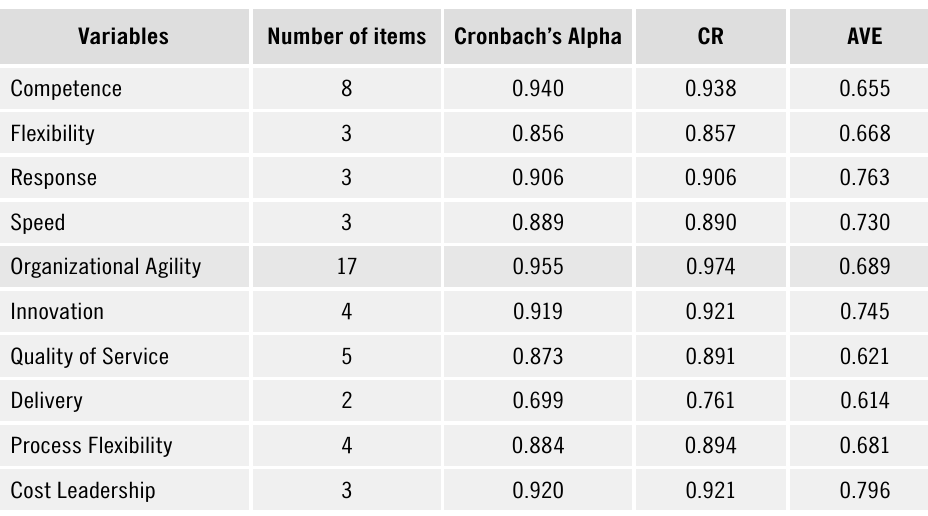
Table 2. Reliability analysis results